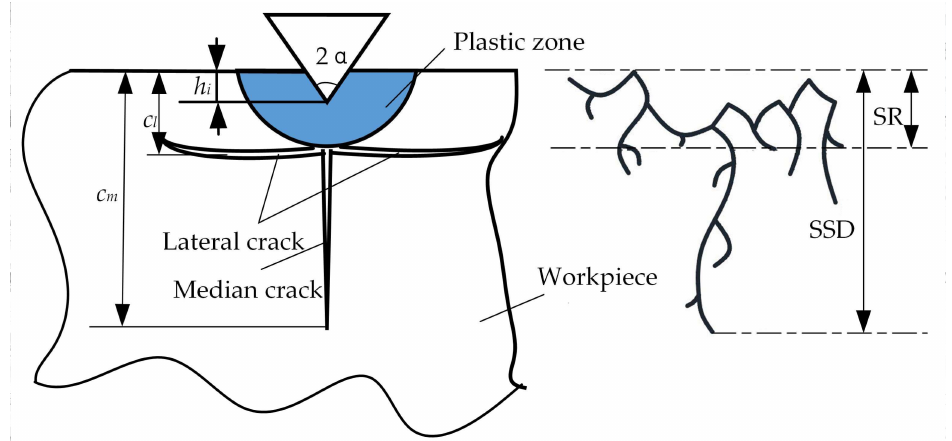
Figure 2. Subsurface damage